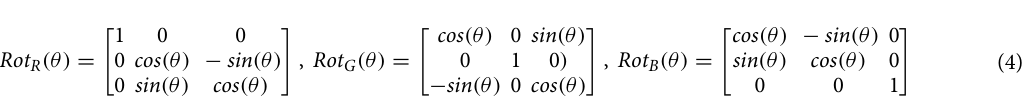
Figure 5. Nonlinear mixup. Step 1: Synthetic image I mix is generated by applying standard mixup on two reference images from the training set (original and WGAN-div generated images). Step 2: I mix is further transformed to a nonlinear mixup image by applying 3D rotation to each pixel about one of the axes at angle θ in RGB colour